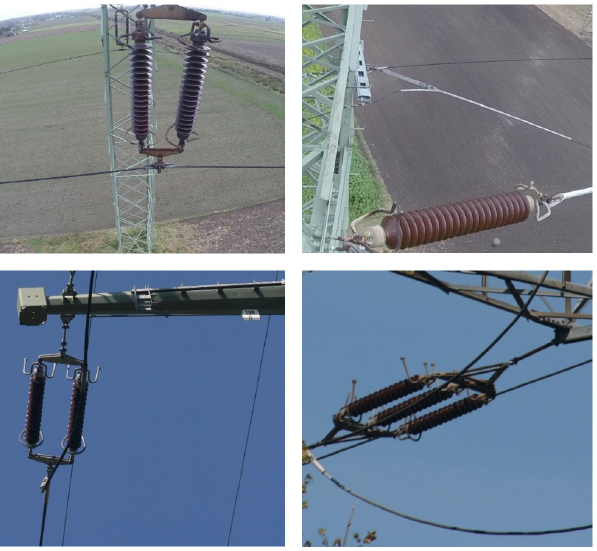
Figure 3. Example images of power line insulators from the prepared data